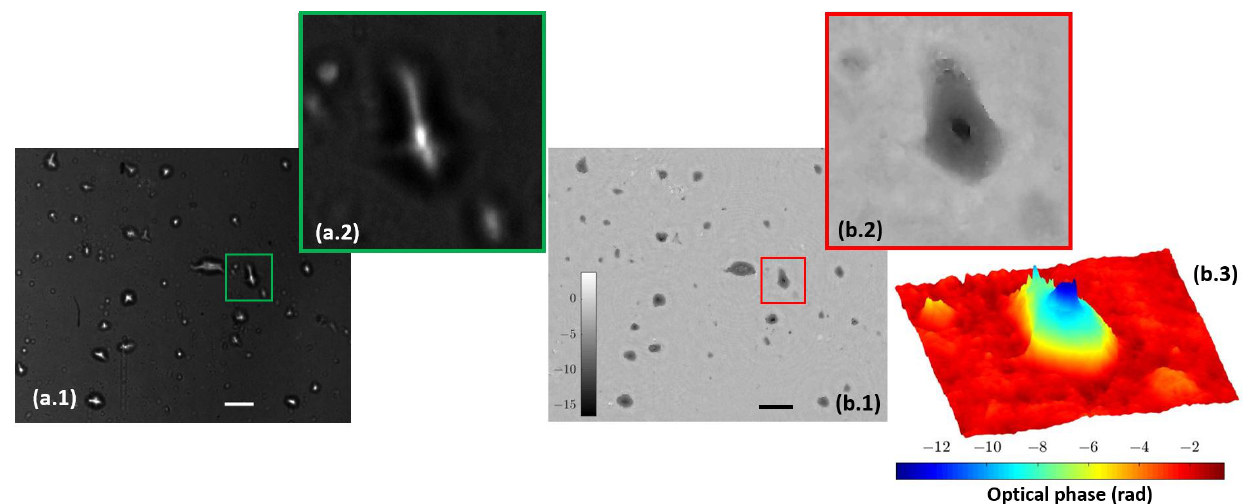
Figure 8. Lab-made cultures cells stained with fluorescein. ( a.1 ) Full field image of the fluorescent arm; ( a.2 ) includes magnification of a single cell. ( b.1 ) Full field image of the phase distribution; ( b.2 , b.3 ) depict the magnification of the same single cell in two and three dimensions, respectively. Scale bars are 50 µm length.